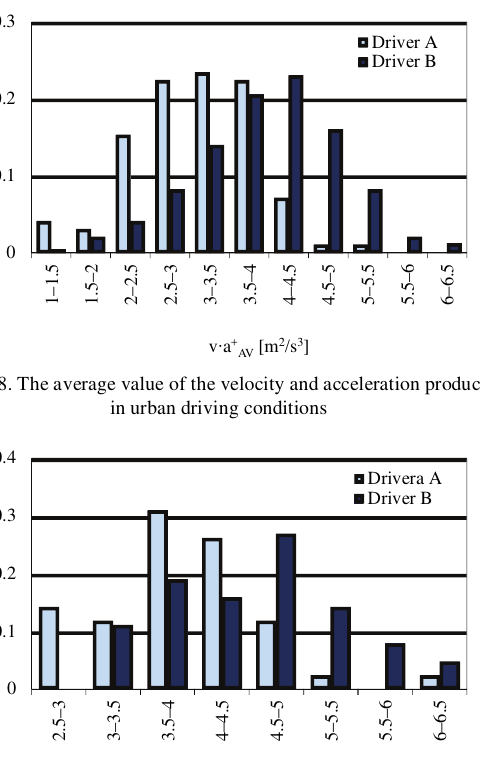
Fig. 17. The average value of the absolute value of the velocity and acceleration product in extra-urban driving conditions